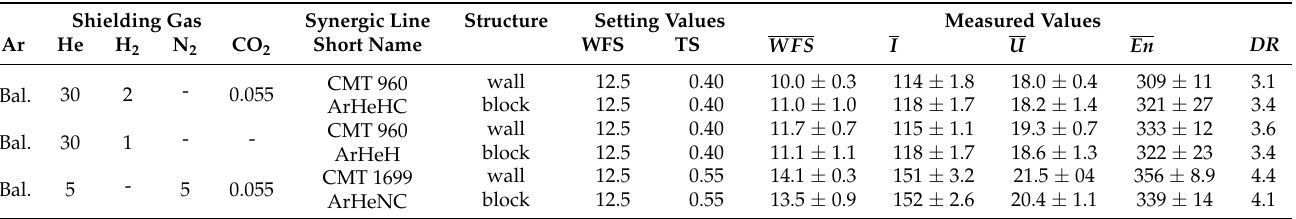
Table 4. Process parameters of different WAAM structures with HY282 ( Φ 0.035 ″ ) and variable CMT synergic lines and shielding gases (flow rate: 18 L/min; stick-out: 12 mm).